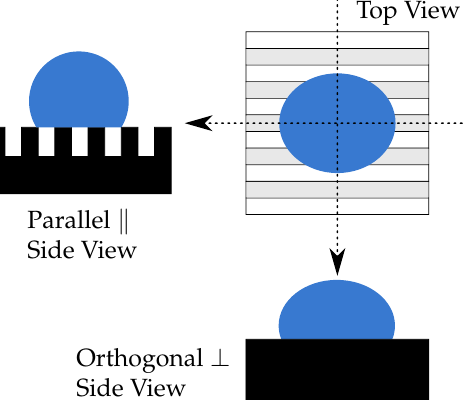
Figure 11. Different viewing angles for CA measurements on lamellar MAE surfaces. In the direction, the line of sight is parallel to the surface structures (long side of lamellas). In the the viewing axis is orthogonal to the long side of the lamellas.